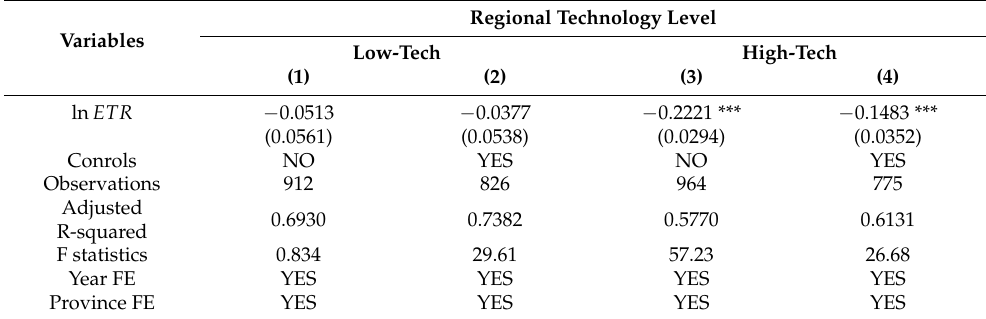
Table 6. Heterogeneity analysis: